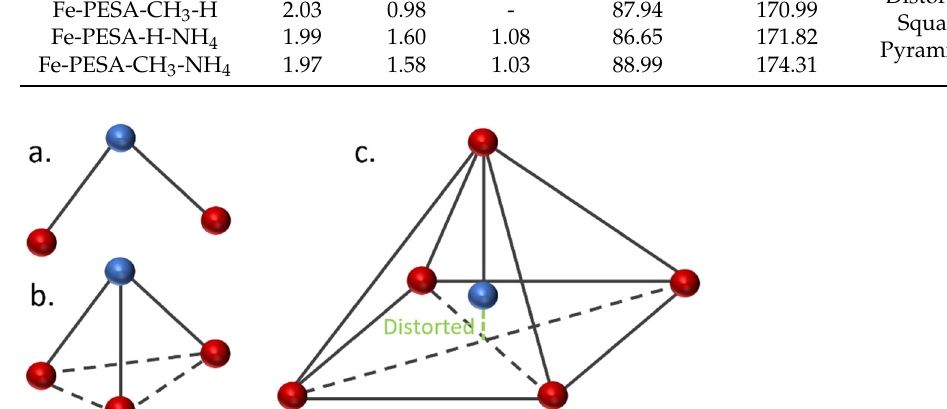
Figure 4. Demonstration of the geometrical structures of Fe-PESA-1n, ( a ) bent and ( b ) trigonal pyramidal, and Fe-PESA-2n ( c ), distorted square pyramidal.